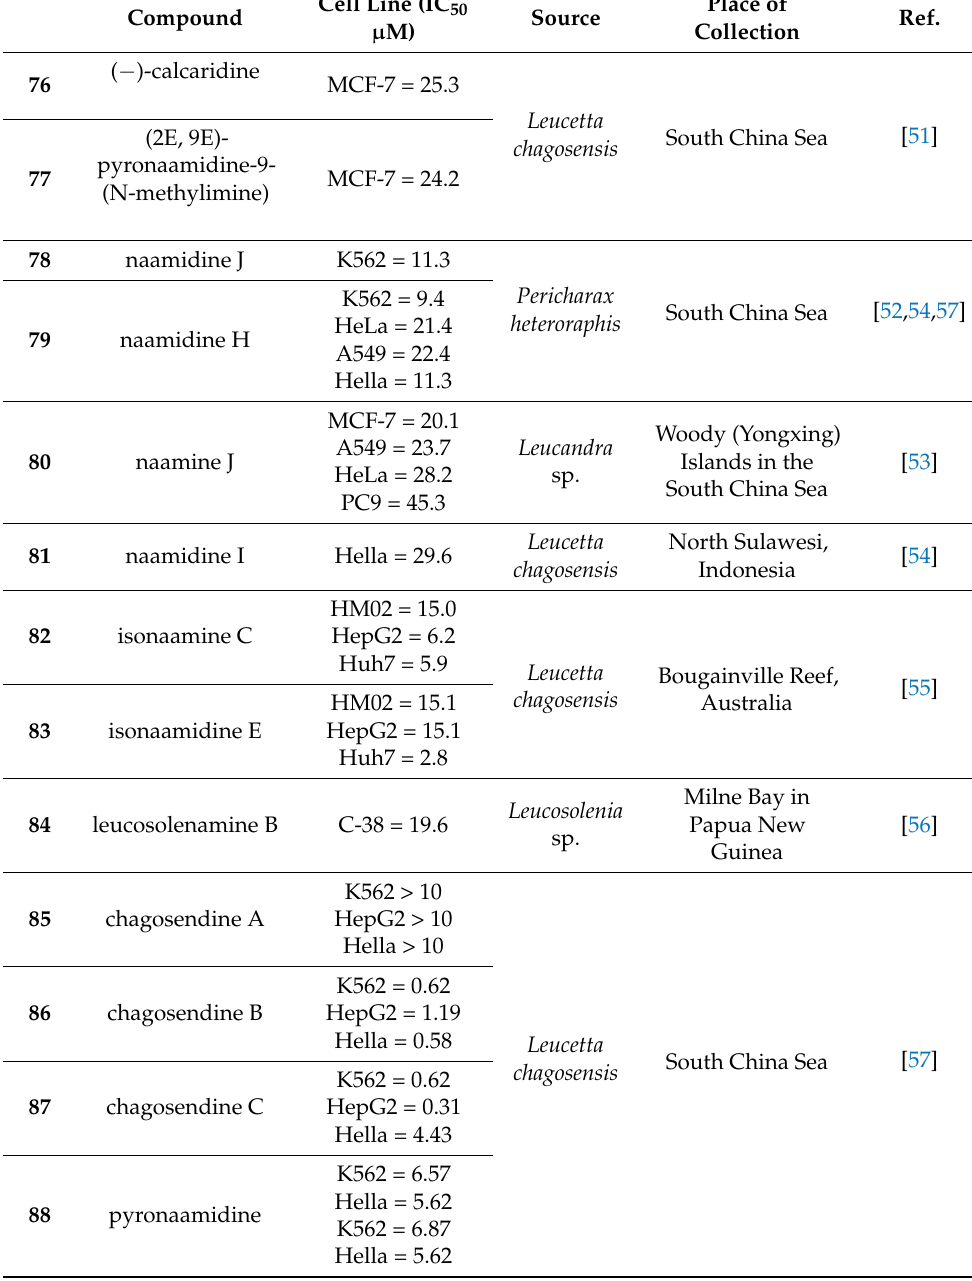
Table 7. Cytotoxic effects of Imidazole